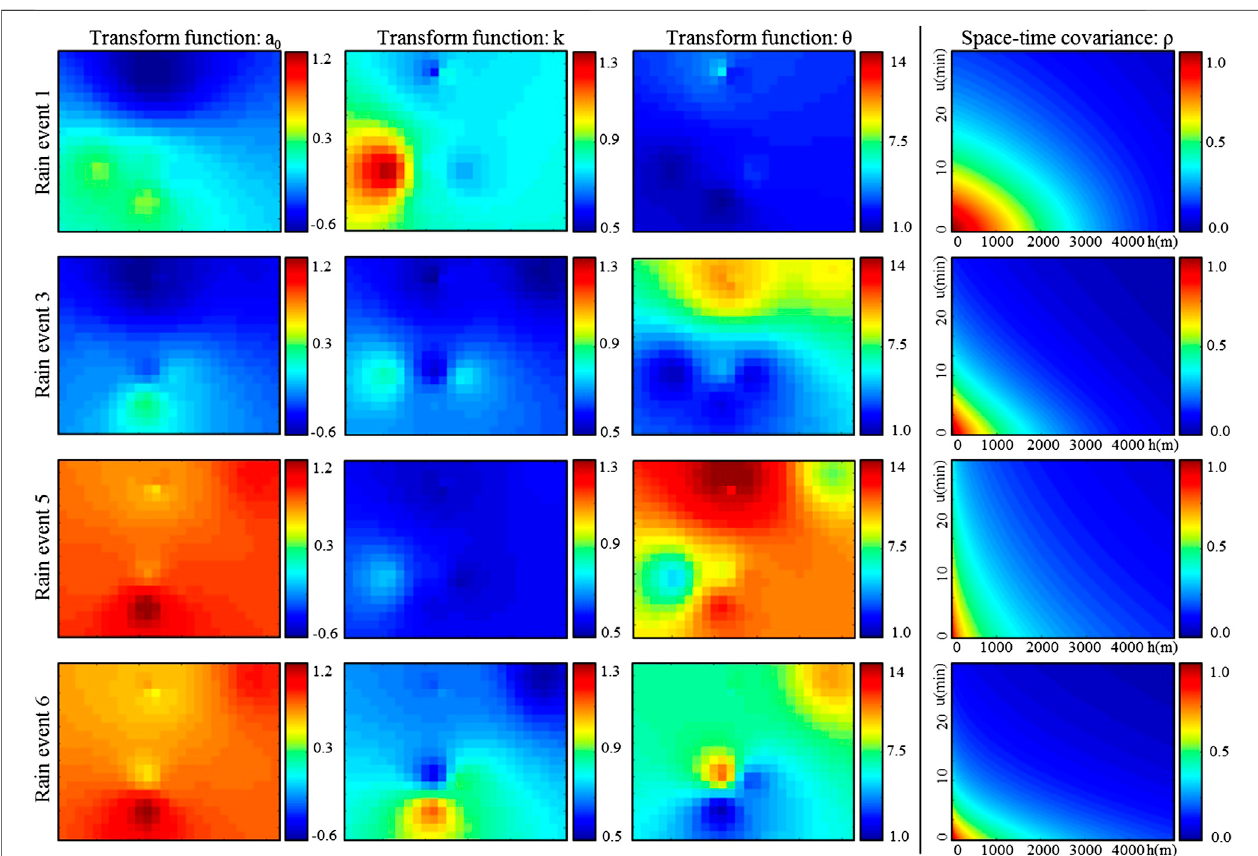
FIGURE8| Modelparametersinferredfor,fromtoptobottom:Event1,3,5and6.Fromlefttoright:mapsoftheparametersofthetransformfunction(a 0 ,kand θ ), and space-time covariance of the latent fi eld. Here the covariance of the latent fi eld is expressed in a Lagrangian reference frame moving with the rain storm (advection velocity:5.8 m/sforEvent1,1.2 m/sforEvent3,0.3 m/sforEvent5,and0.3 m/sforEvent6;advectiondirection:252 ° forEvent1,165 ° forEvent3,260 ° forEvent5,and 160 ° for Event 6).